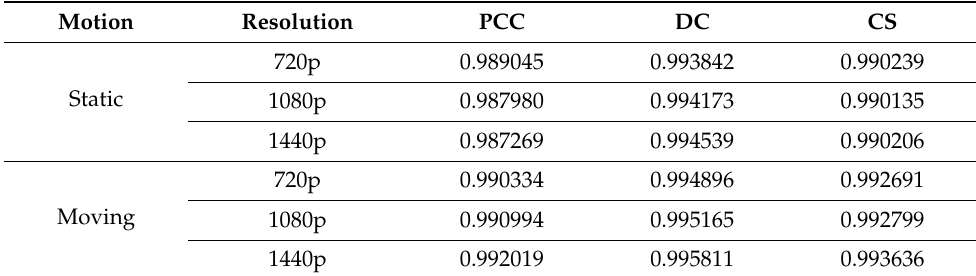
Table 2. Correlation of time consumption across five components between Zeus and the commer- cial system.